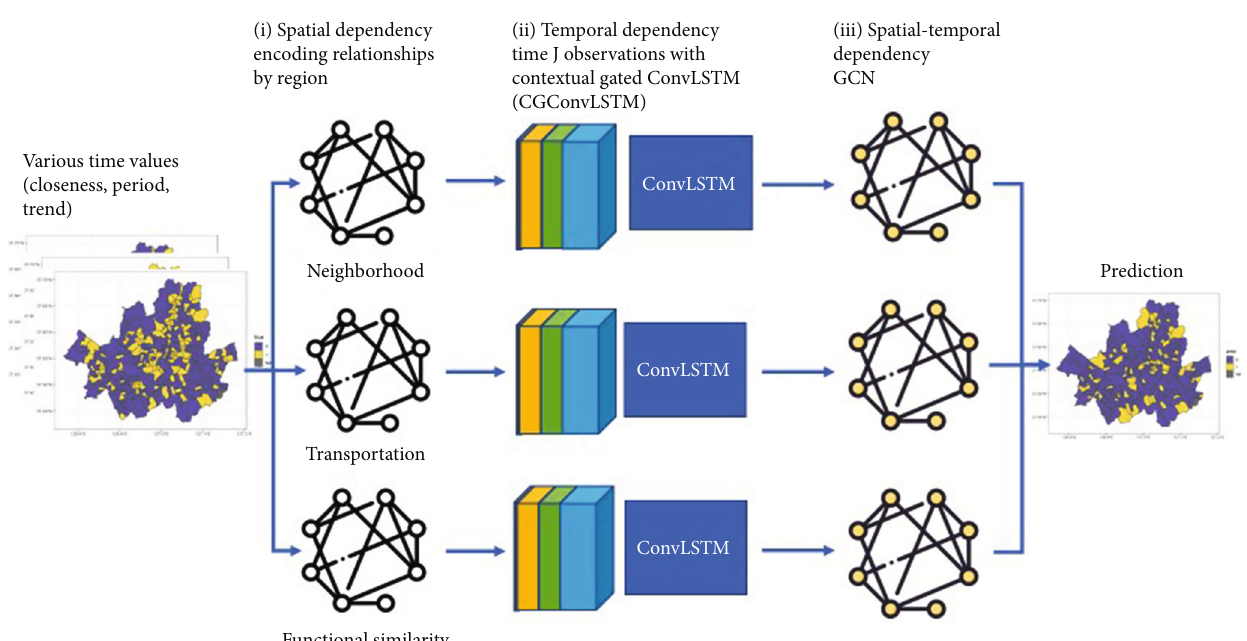
Figure 2: Model overview.